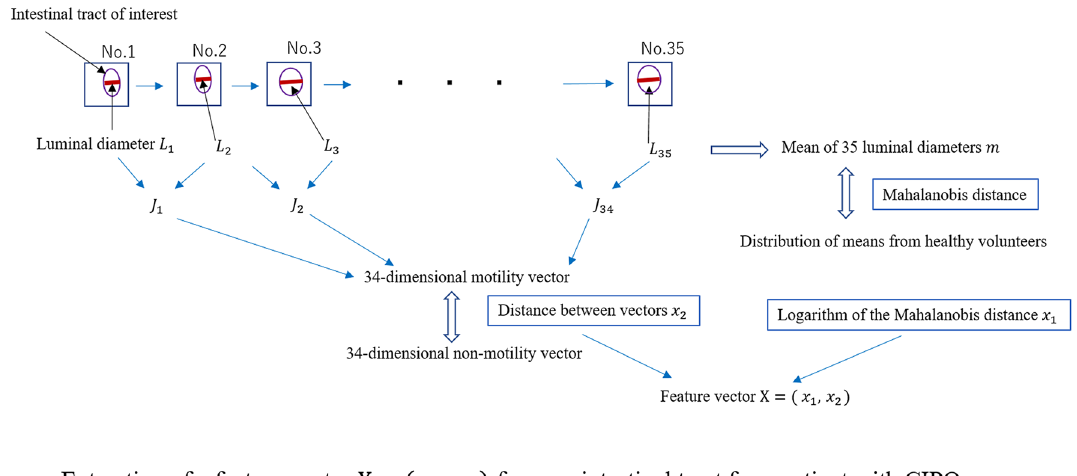
Figure 3. Process of extracting a two-dimensional feature vector from an intestinal tract of interest for a patient with chronic intestinal pseudo-obstruction in magnetic resonance